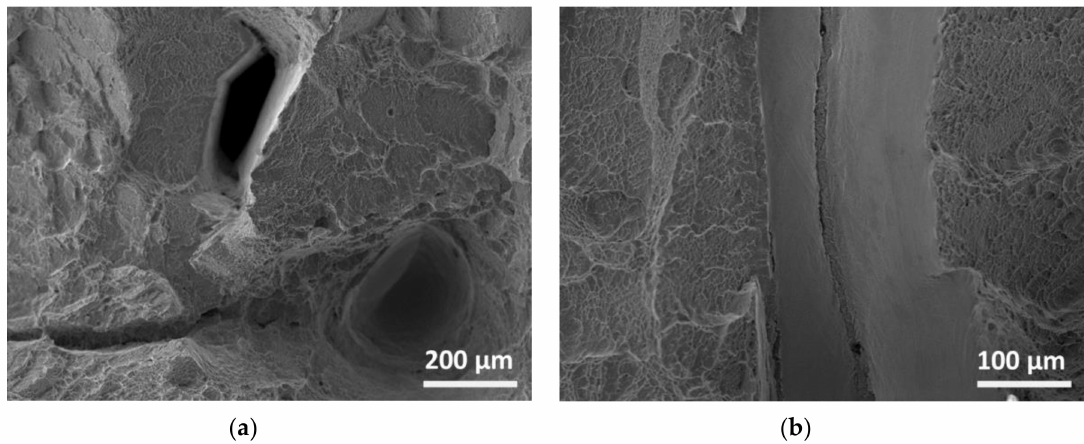
Figure 11. SEM micrographs of the fractured surfaces of Charpy V-notch specimens: ( a ) as-deposited in LD-orientation and ( b ) PWHT in TD-orientation specimens.